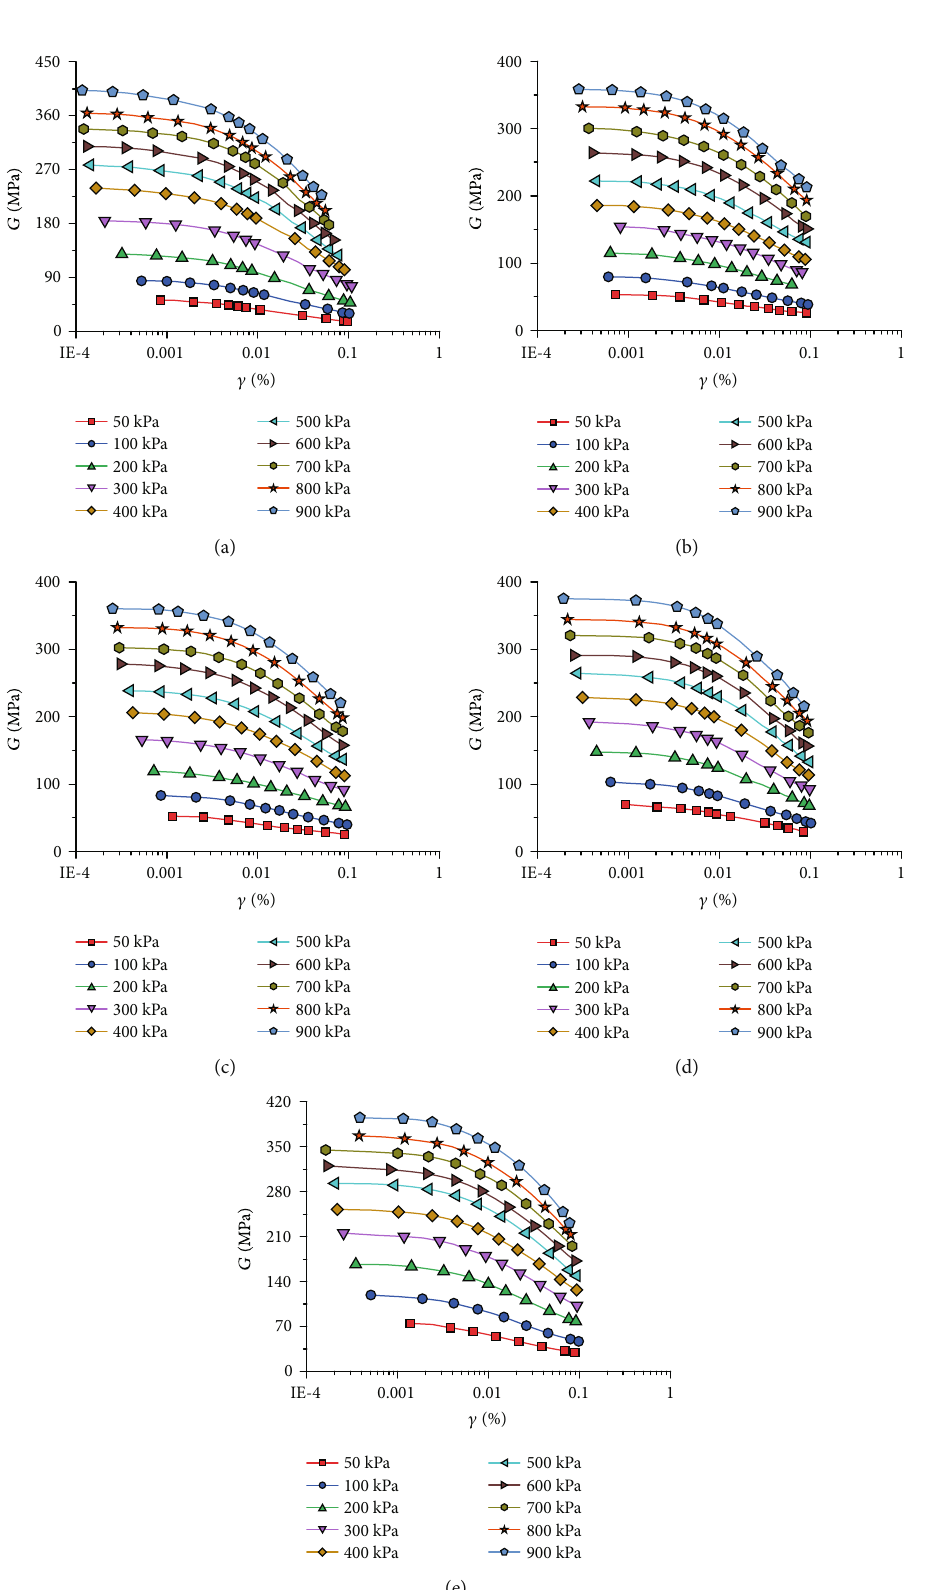
Figure 4: Relationship between G and γ : (a) undisturbed HWG; (b) HWG R1; (c) HWG R2; (d) HWG R3; and (e) HWG R4. (Data points